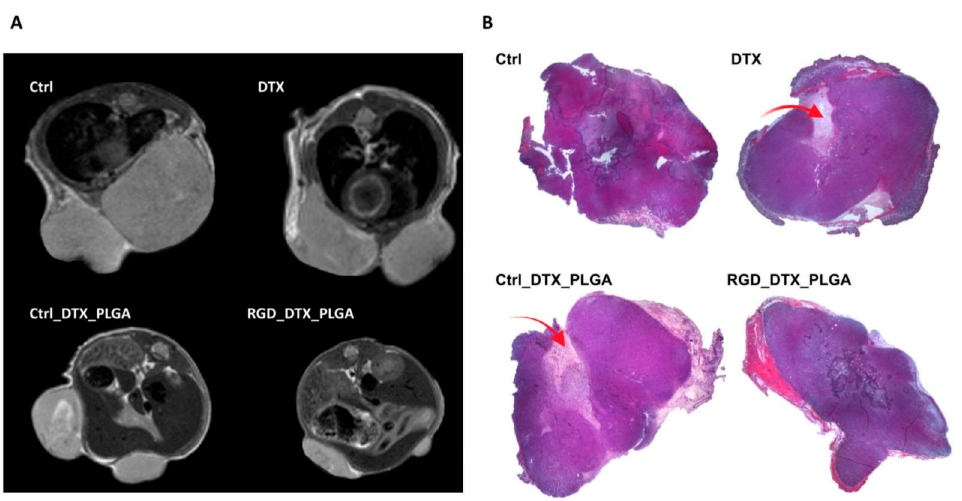
Figure 7. MRI and histological analyses of 4T1 tumors from mice treated with free docetaxel or with PLGA-NPs containing docetaxel. ( A ) Representative axial T 2w -MR images of tumor region in mice treated with physiological saline solution as a control, free docetaxel (DTX), Ctrl_PLGA or RGD_PLGA (N = 6 per group). ( B ) Representative hematoxylin/eosin histological staining of 4T1 tumors of mice belonging to the four groups of treatment. The red arrows highlight the necrotic areas.